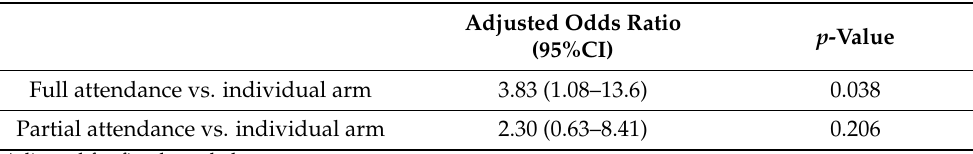
Table 4. Impact of attendance in group care sessions on improvement of knowledge, results from a multivariate logistic regression model